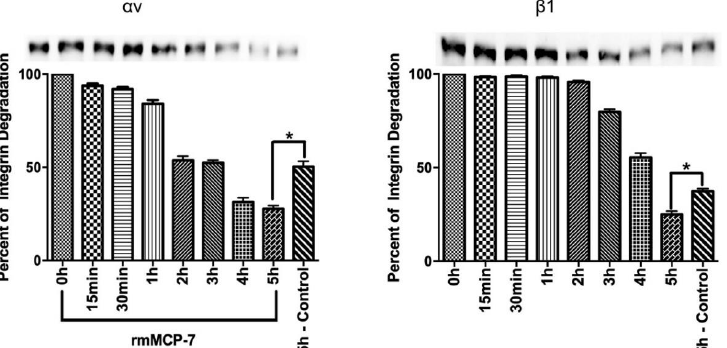
Figure 4. The αv and β1 integrin subunits were degraded by rmMCP-7. A basal degradation of the integrin subunits is observed in the absence of rmMCP-7 (control). The recombinant integrin was incubated for 5 h in the presence or absence (control) rmMCP-7. Integrin levels were analyzed by Western blot. The graphs show the quantification of Western blot bands by densitometry. Data from three independent experiments. * p < 0.05.